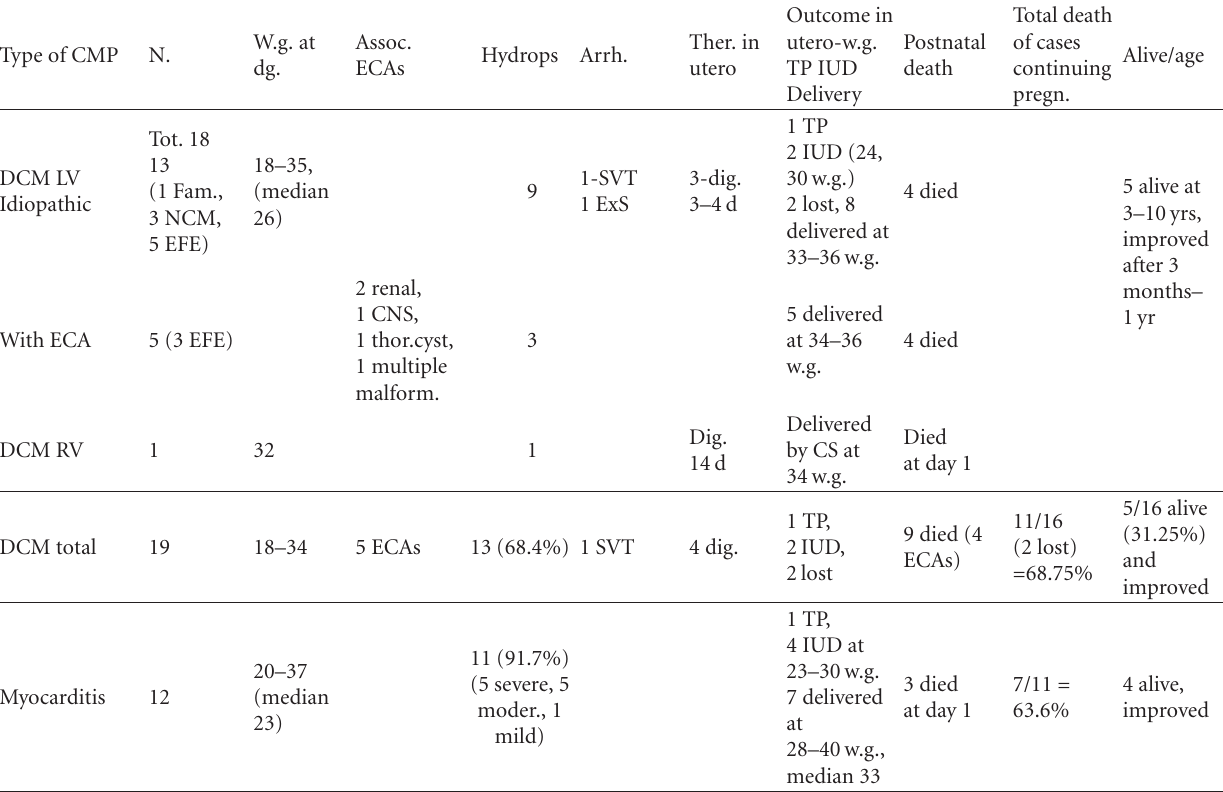
Table 1: Data of cases with DCM and